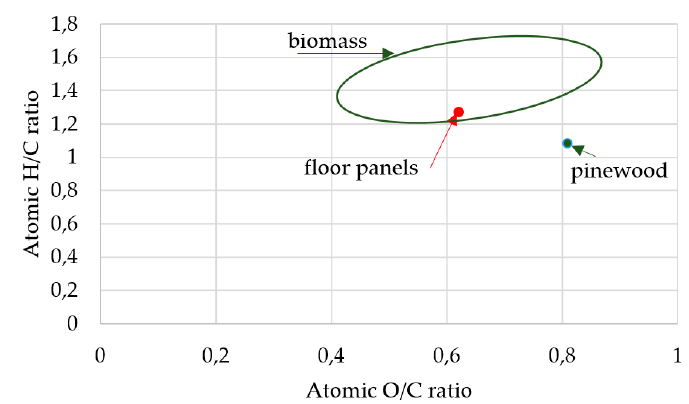
Figure 1. Illustration of the position of waste from floor panels in the Van Krevelen system (author’s own study) [24,26].